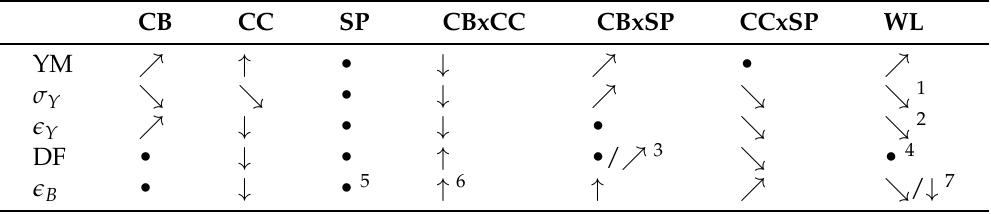
Table 2. Summary of formulation and weld-line effects. 1 At a 60% CC loading, a much stronger decrease in WLF occurs than at the other loadings. 2 At a 0% CC loading, WLs have a positive effect, but this is offset by a strong negative effects at the other loadings. 3 In WL specimens, no notable interactive effect is seen, but a fairly strong synergism appears in REF specimens. 4 At a 0% CC loading, WLs have a slightly positive effect, but this is countered by negative effects at the other loadings. At these higher loadings, CB increases the difference between WL and REF